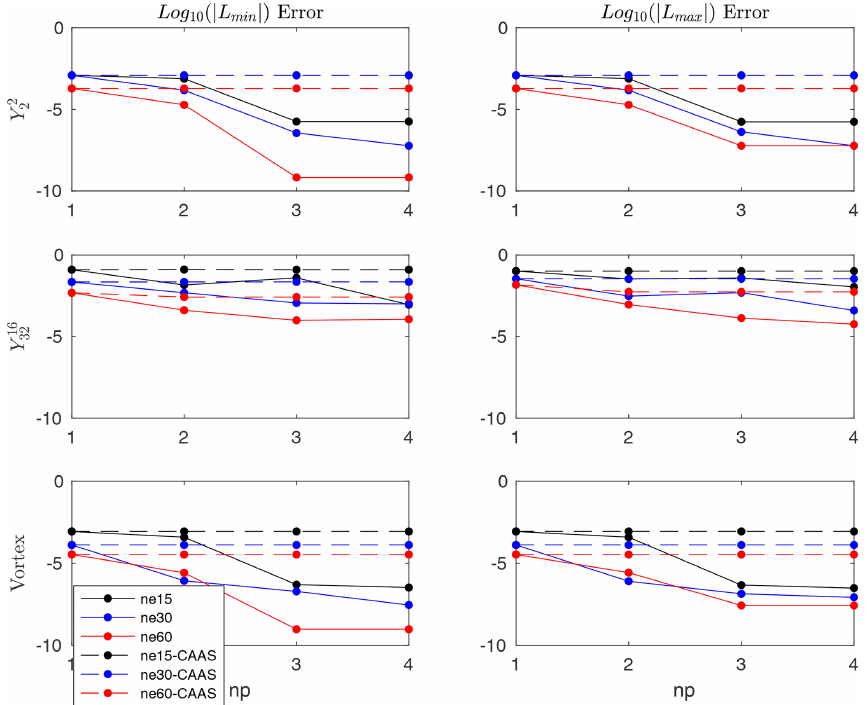
Figure 2. Convergence test for finite-volume to finite-volume remapping from a cubed sphere to a 1 ◦ latitude–longitude mesh for three different test cases. Note that in all cases for np > 1, the remapped field overshoots and undershoots the absolute maximum and minimum,